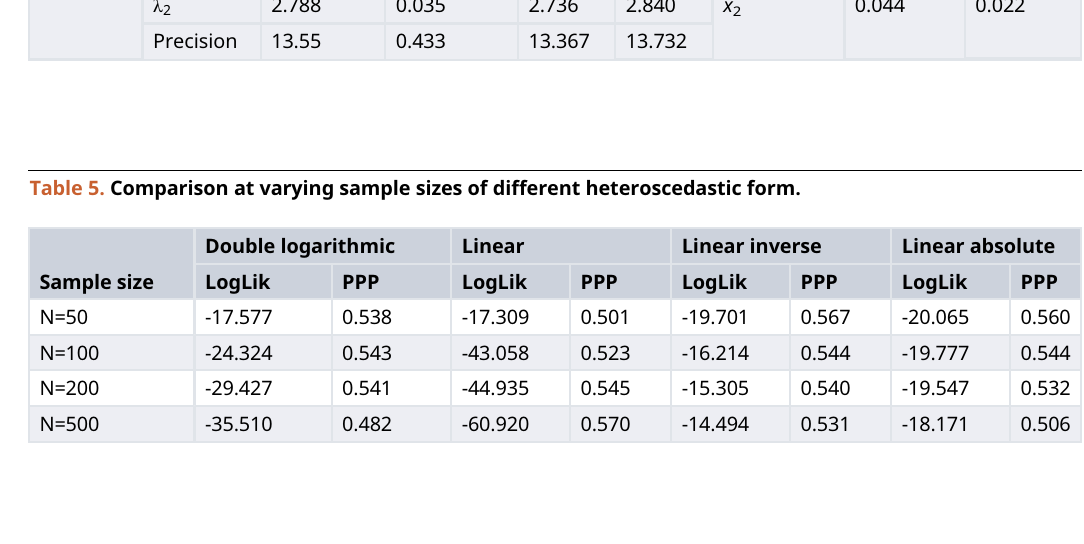
Table 6. Latent variable estimates at different sample sizes under the double-logarithmic and linear